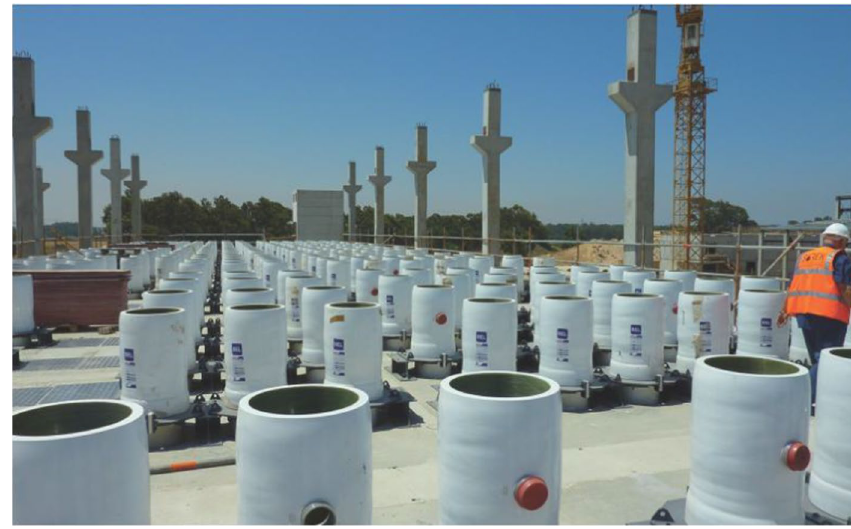
Fig. 12 The largest reverse osmosis site in the world with 624000 m 3 /day capacity (Ben- nett